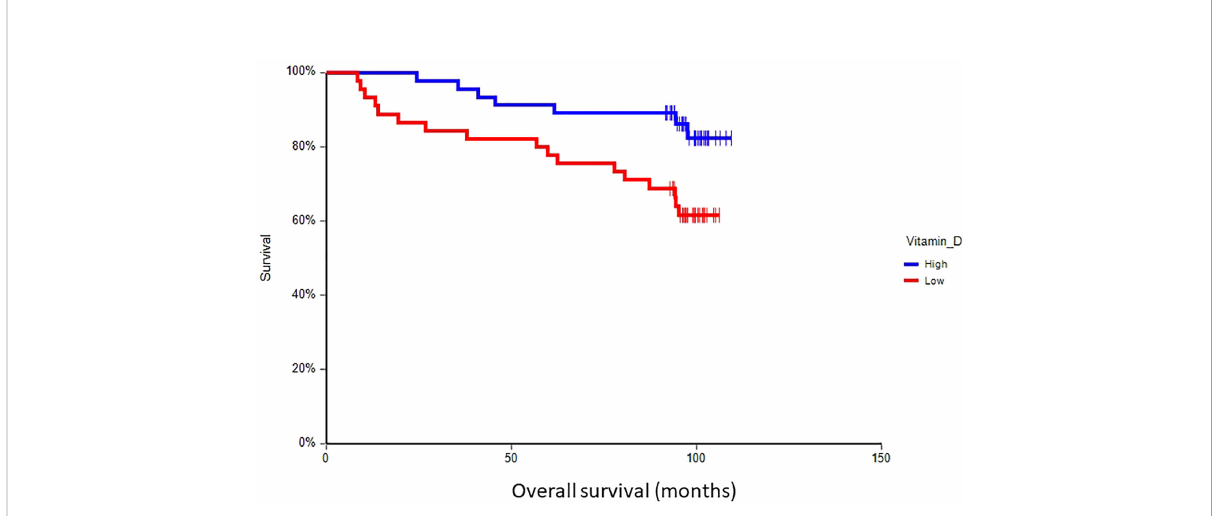
FIGURE 3 Kaplan – Meier estimates of probabilities of overall survival according to plasma vitamin D levels in primary breast cancer patients (n = 91). Patients with plasma vitamin D levels above median had signi fi cantly better OS as compared to patients with lower vitamin D levels (HR = 0.36, 95% CI 0.16 – 0.80, p = 0.017; 0 = plasma vitamin D level below median, 1 = plasma vitamin D level above median). OS, overall